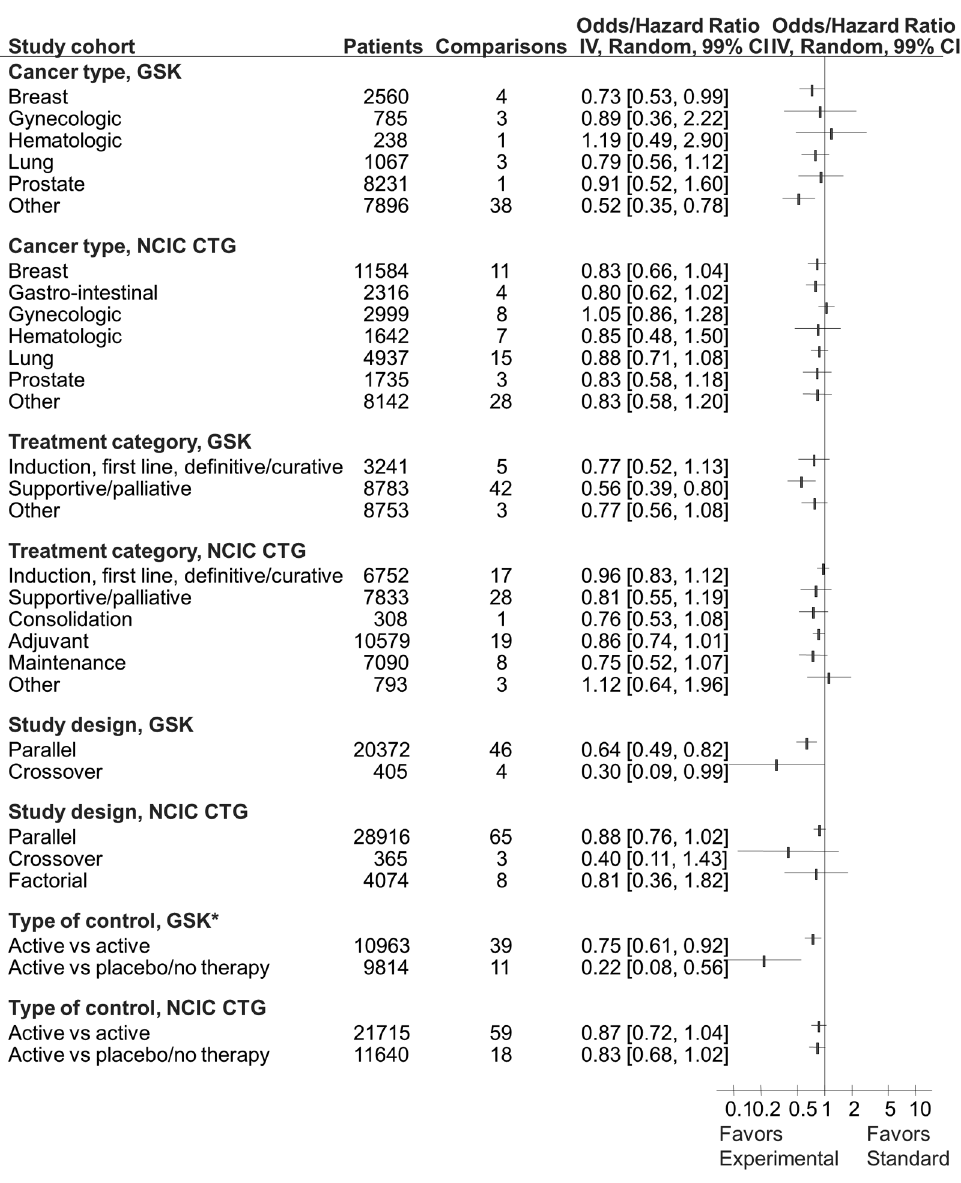
Figure 8. Forest plot of sensitivity analysis for distribution of success rate according to cancer and treatment type, study design, and choice of control for GlaxoSmithKline (GSK) and National Cancer Institute Canada Clinical Trials Group (CTG) cohorts. The summary pooled estimate (odds/hazard ratio) is indicated by rectangles, with the lines representing 99% confidence intervals (CIs). * Represents a statistically significant test for interaction between subgroups. Note that the experimental treatments were statistically superior in GSK trials where comparators were placebo or no therapy.